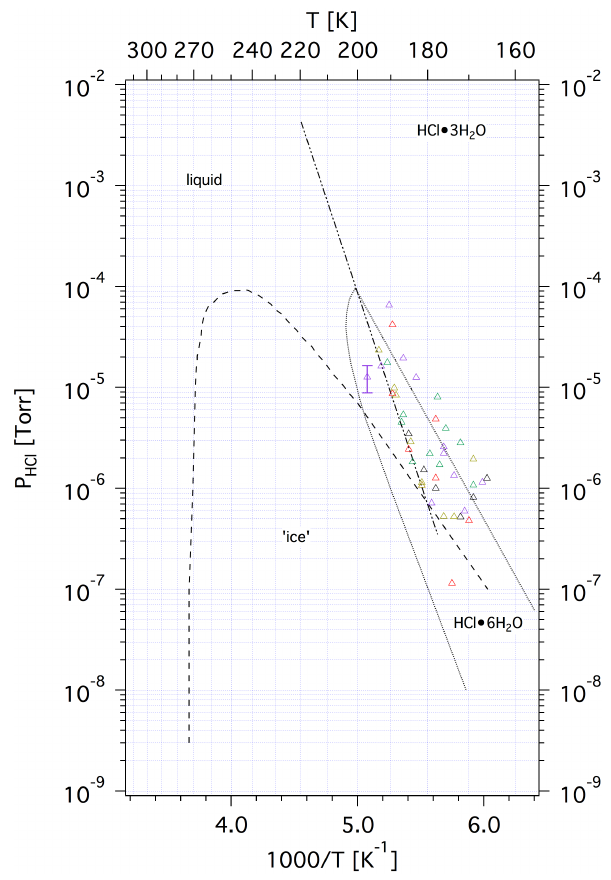
Figure 6: Binary phase diagram of the HCl/H 2 O system. The empty triangles 1226 Figure 6. Binary phase diagram of the HCl/H 2 O system. The represent calculated values of P eq (HCl) for HH using the kinetic data for adsorption 1227 empty triangles represent calculated values of P eq (HCl) for HH us- ing the kinetic data for adsorption and desorption of the present and desorption of the present work. Different colours represent different experiment 1228 work. Different colours represent different experiment